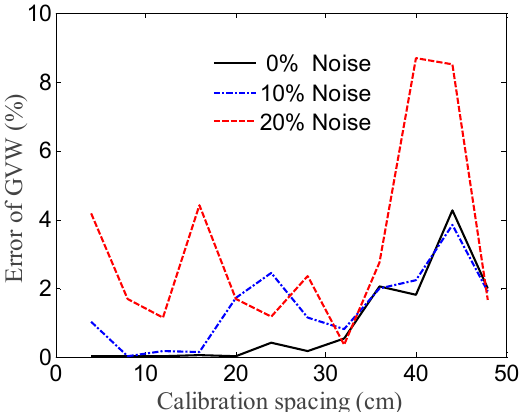
Figure 10. Identification error of the GVW under different calibration spacing d.